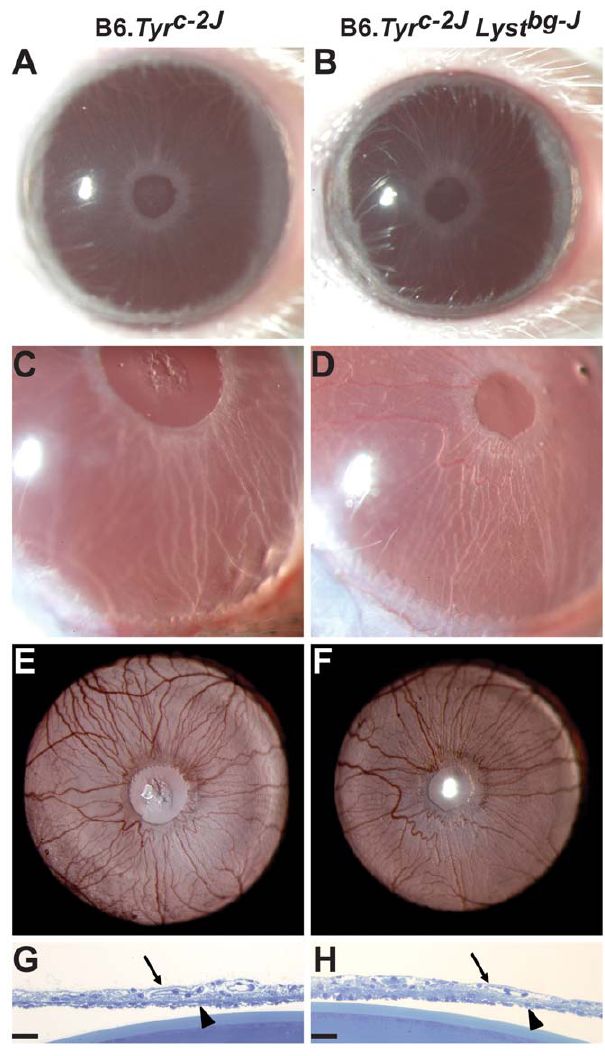
Figure 2. Albinism rescues Lyst -mutant iris phenotypes. Different views of B6. Tyr c-2J eyes ( left column ) and B6. Tyr c-2J Lyst bg-J eyes ( right column ), indicating that Lyst -mutant iris phenotypes are completely rescued by albinism. (A, B) Broadbeam illumination reveals that mice of both genotypes have an intact iris. (C, D) At higher magnification, both genotypes have a normal appearing inferior anterior chamber that lacks the accumulations typically observed in pigmented B6- Lyst bg-J eyes. (E, F) Transilluminating illumination reveals that both genotypes have a pattern typical for albino eyes, and lack any indication of the concentric pattern characteristic of B6- Lyst bg-J eyes. (G, H) Histologic sections of B6. Tyr c-2J and B6. Tyr c-2J Lyst bg-J irides are indistinguishable, both showing an intact iris stroma ( thin arrows ) and iris pigment epithelium ( arrowheads ). A portion of the lens is also visible in the bottom of both panels. Images from 3-month-old mice. Images A, C, and E are all from the same eye, as are B, D, and F. Magnifications: A, B (25 6 ); C, D (40 6 , with less image reduction); E, F (25 6 ); G, H scale bars=25 m